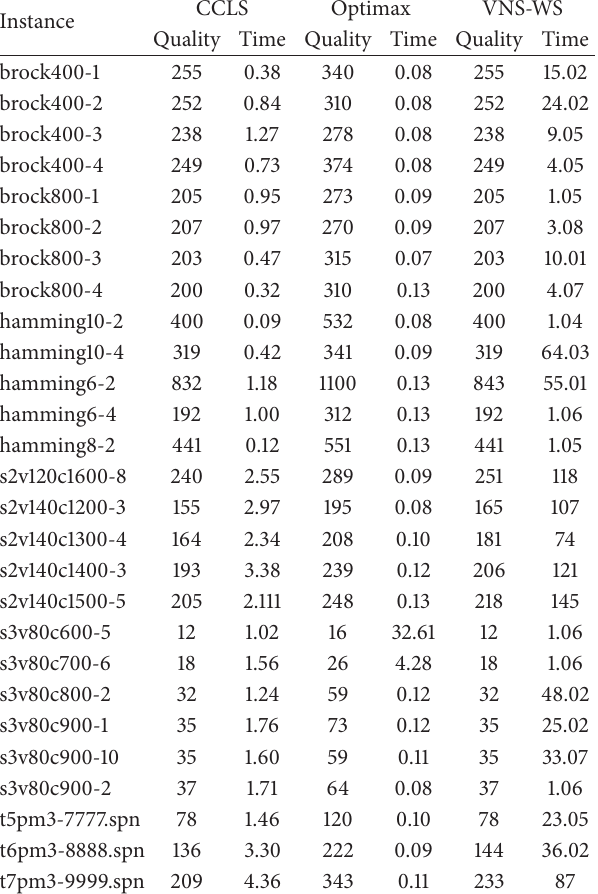
Table 4: Comparing VNS-WS with CCLS and